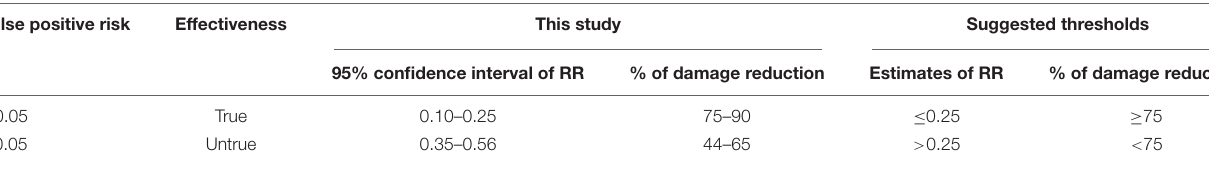
TABLE 1 | Suggested thresholds of the relative risk (RR) indicating the effectiveness of conservation interventions as true or untrue based on the results of this study. False positive